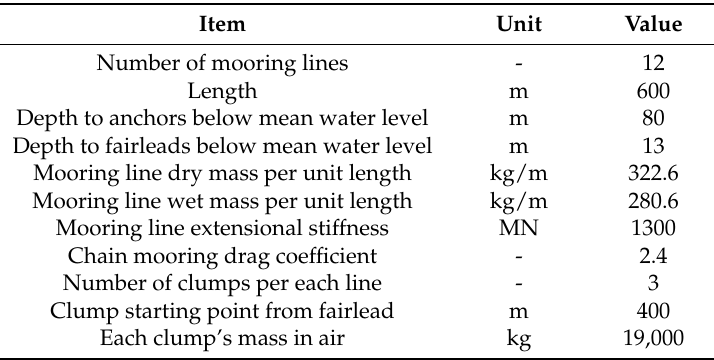
Figure 4. Mooring line arrangements: ( a ) Isometric view; ( b ) Top view. Table 2. Mooring system specifications.